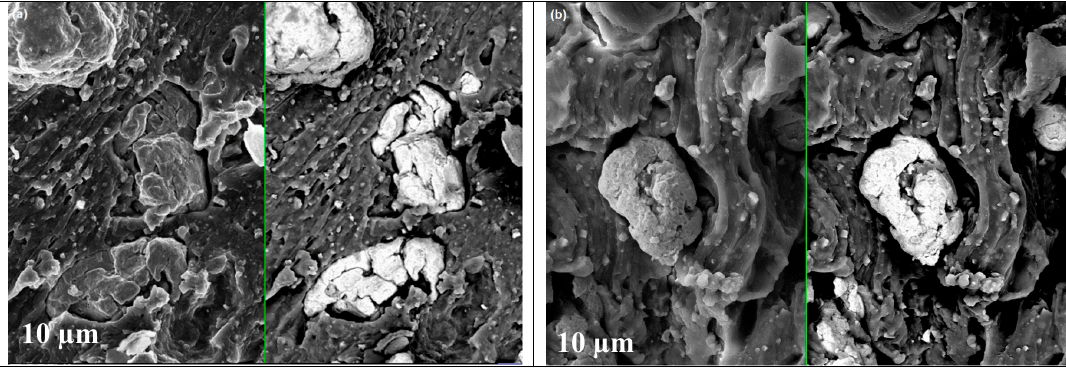
Figure 8. SEM images showing filler–matrix adhesion for the composites A ( a ) and B ( b ).